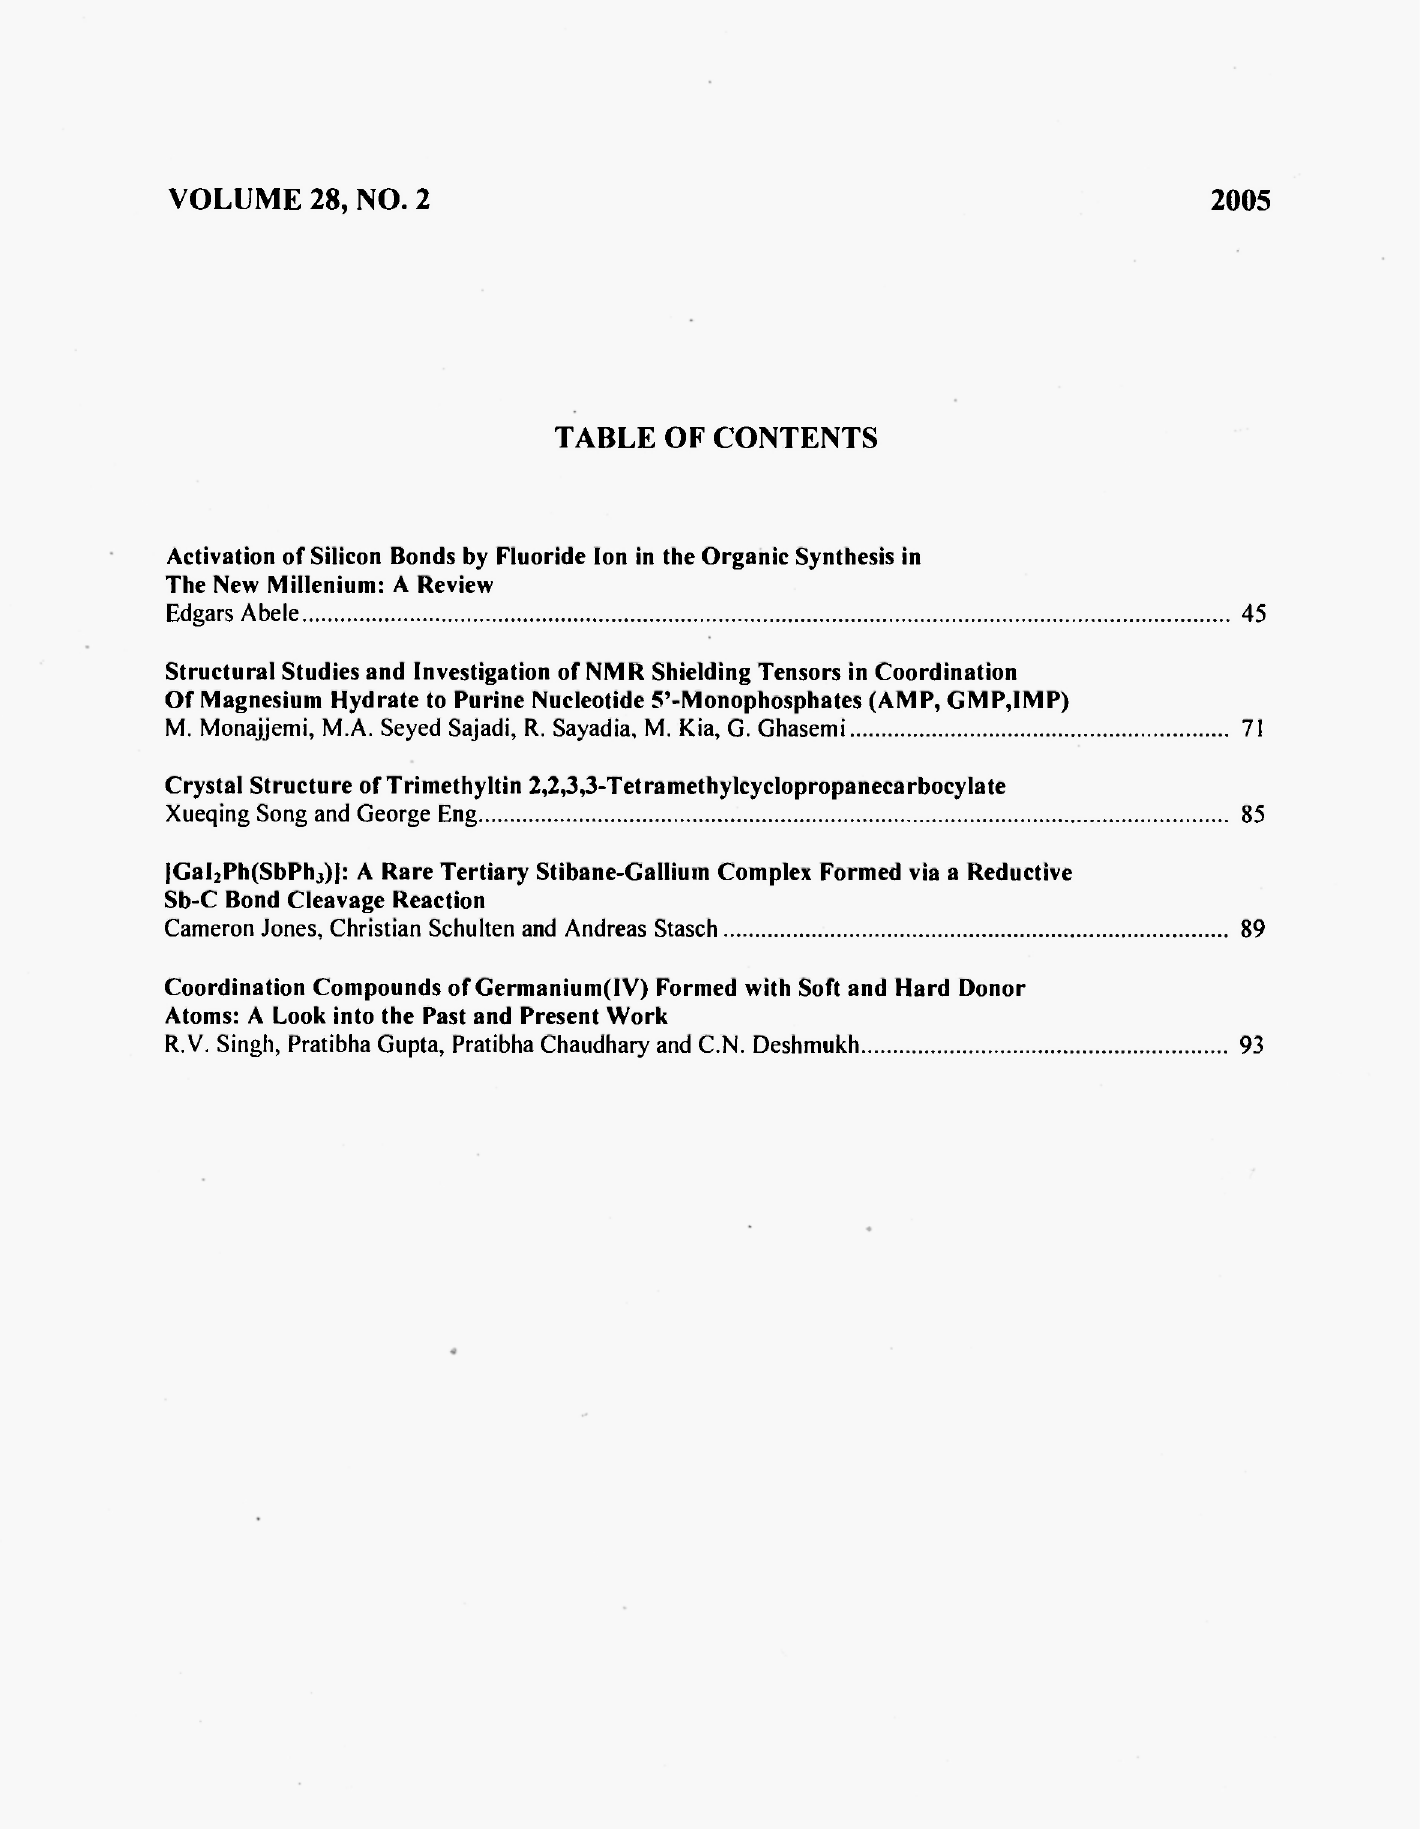
Activation of Silicon Bonds by Fluoride Ion in the Organic Synthesis in The New Millenium: A Review Edgars Abele 45 Structural Studies and Investigation of NMR Shielding Tensors in Coordination Of Magnesium Hydrate to Purine Nucleotide 5'-Monophosphates (AMP, GMP,IMP)